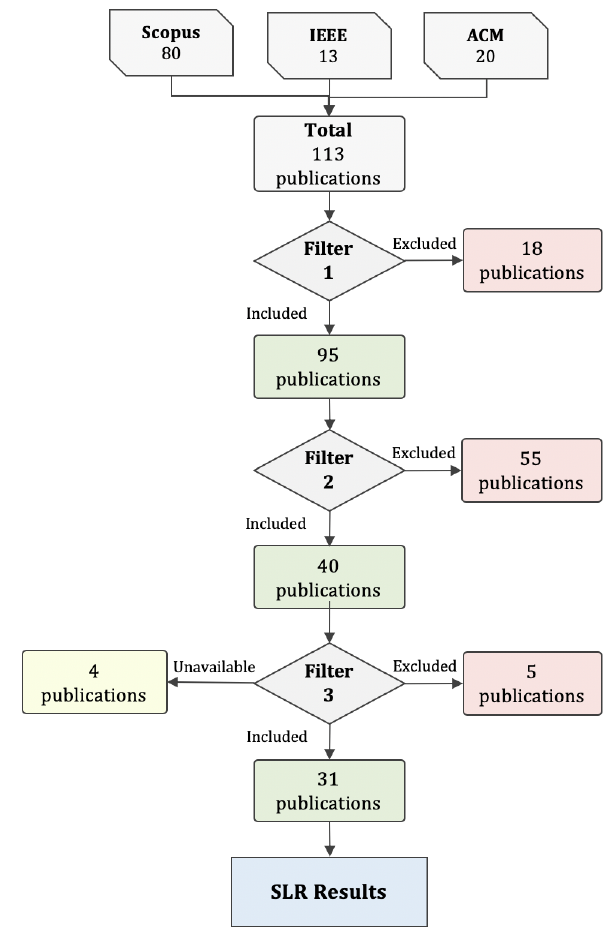
Figure 2. Full research process of paper selection.